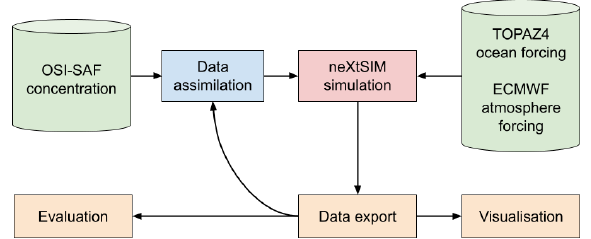
Figure 1. Overall scheme of the neXtSIM-F forecasting platform. Blue block: data assimilation step (pre-processing); red block: run- ning of the model core; light-brown blocks: post-processing steps; green blocks: input data. Note that we only assimilate OSI SAF SS- MIS and AMSR2